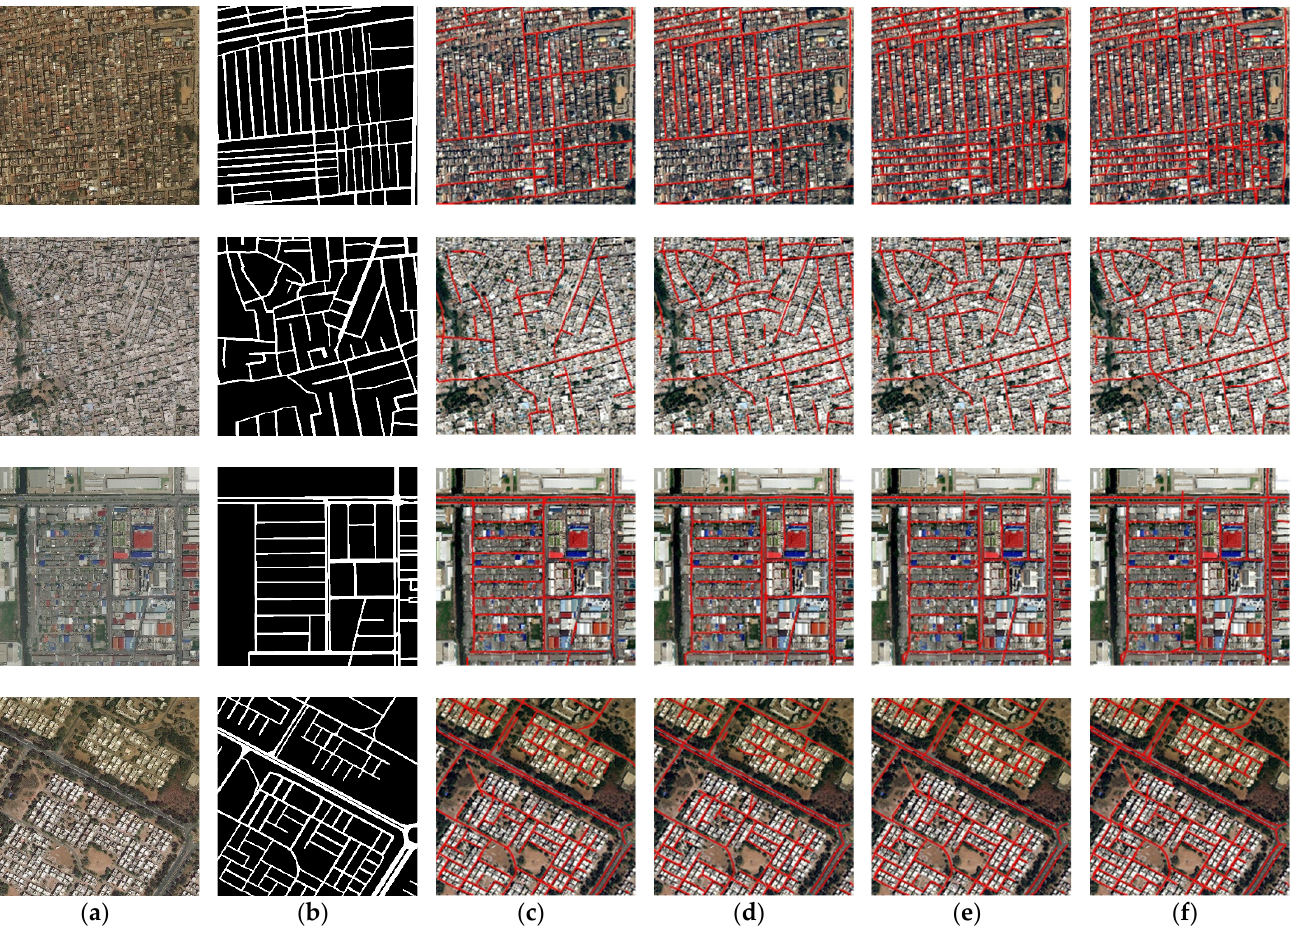
Figure 9. Visual comparisons of road extraction results with different models on urban dense areas of the DeepGlobe dataset: ( a ) input test image; ( b ) corresponding ground truth image; ( c ) results using the LinkNet; ( d ) results of D-LinkNet; ( e ) results of RoadTracer; ( f ) results of proposed Bi-HRNet.